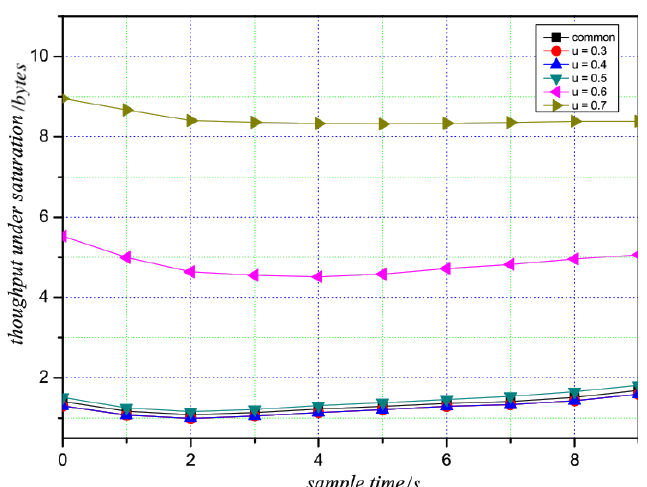
Figure 12. Throughput under different values of µ under saturation.